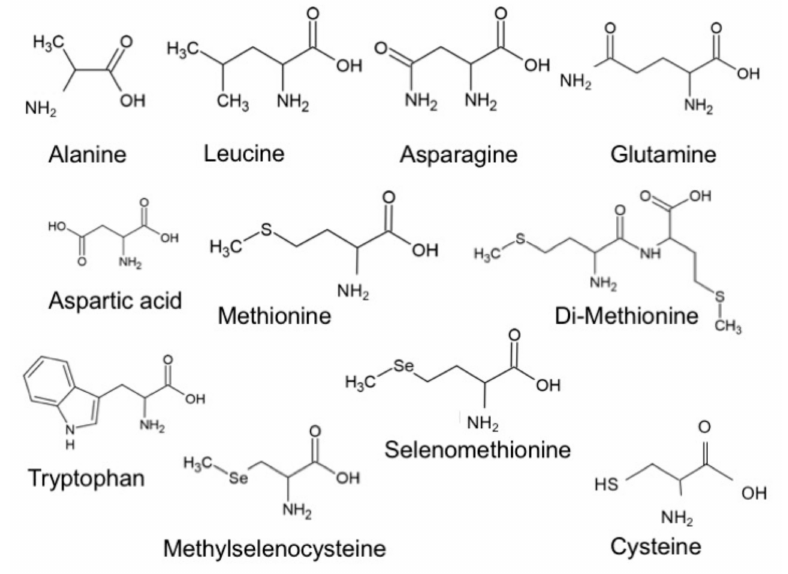
Figure 1. The 10 amino acids and one dimer (di-methionine) analyzed in this